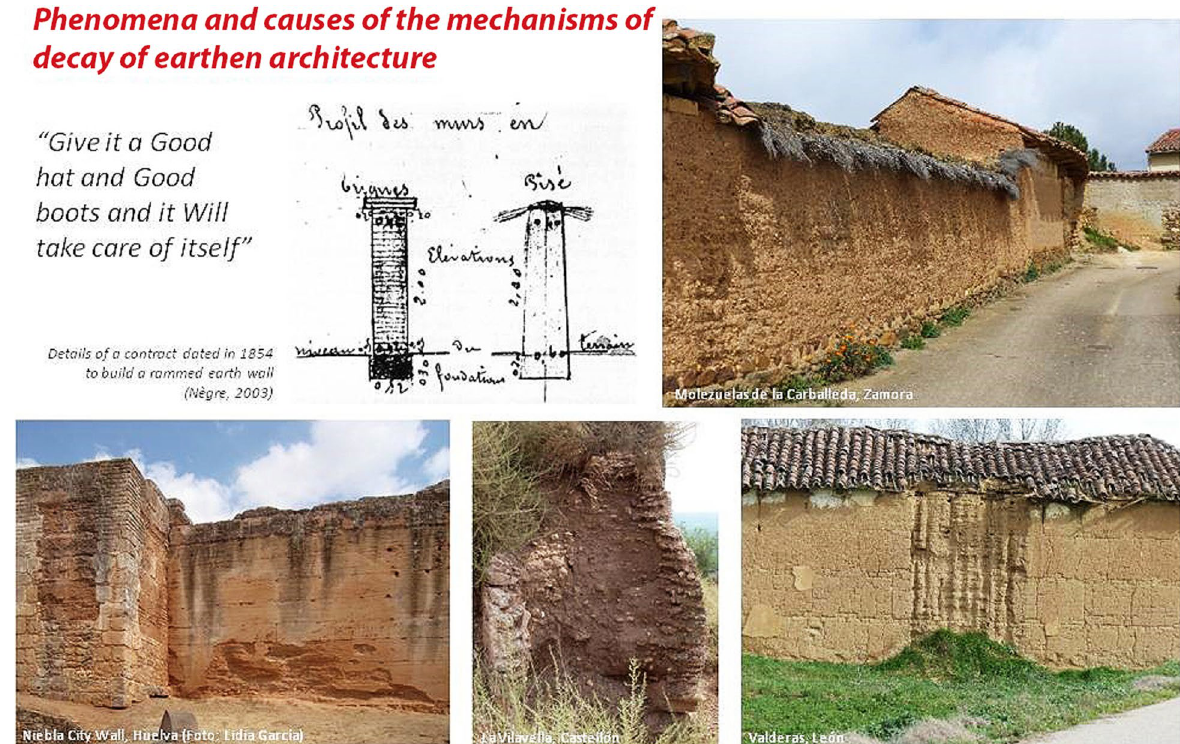
Fig. 4 Analysis of degradation phenomena by constructive technique, variant and wall section affected. Examples of degradations of the rammed earth group affected (Source: RES‑TAPIA & SOS‑TIERRA